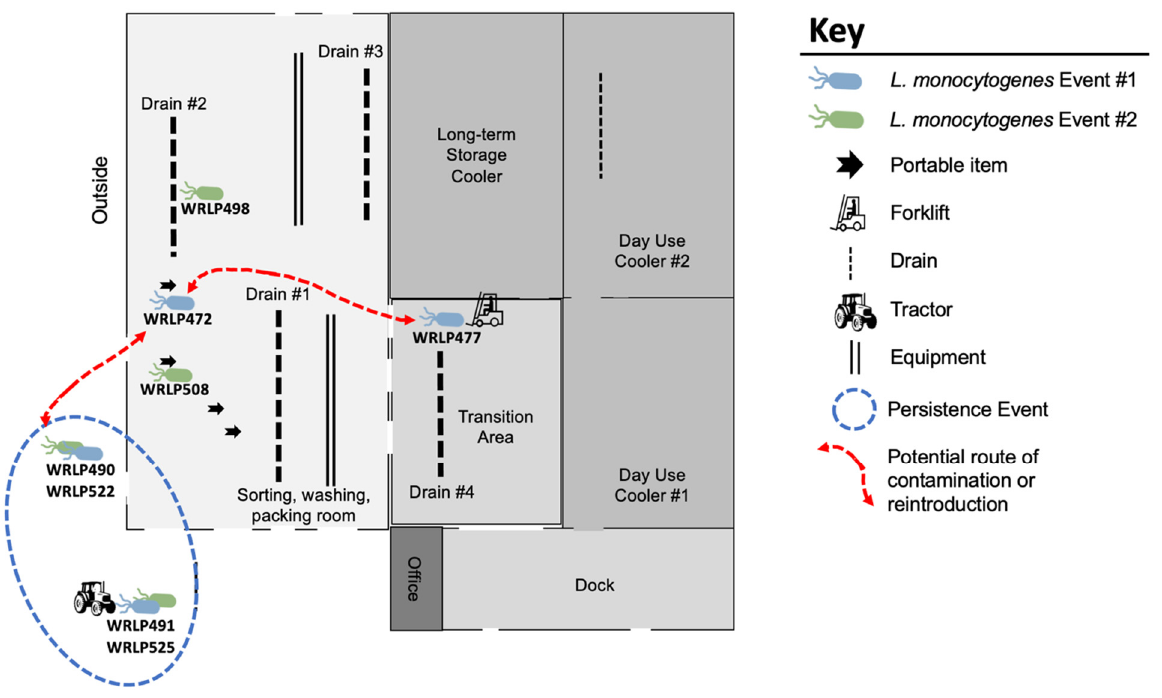
Figure 3. Sampling locations of isolates belonging to CC37 found throughout the facility, with 0–2 SNP differences over two different sampling events. Blue circle depicts suspected source of persistent L. monocytogenes and red arrows show a potential route of contamination into the facility.